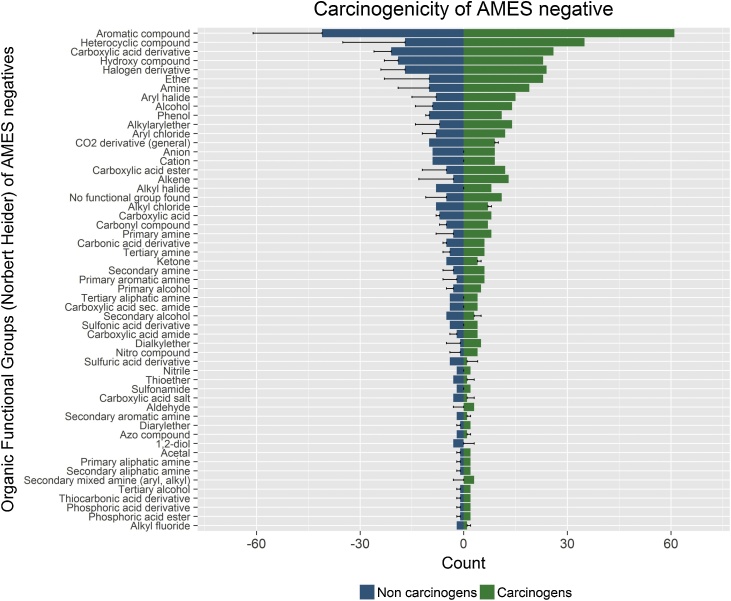
The distribution of OFCs (Organic Functional Groups) for the Ames-negative substances in the database. Bar plots showing the characteristics of the substances in the Ames-negative dataset as described by the number of fragments identified using the “Organic Functional Groups (Norbert Heider)” profiler (OECD QSAR Toolbox 4.1)[11,29]. For readability, only fragments found in more than 3 substances are shown. For each functional group, the error bars indicate differences in the numbers of rodent carcinogens and non-carcinogens.